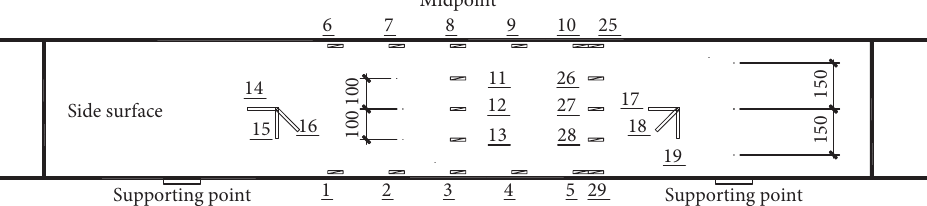
Figure 4: Arrangement of concrete strain gauges.